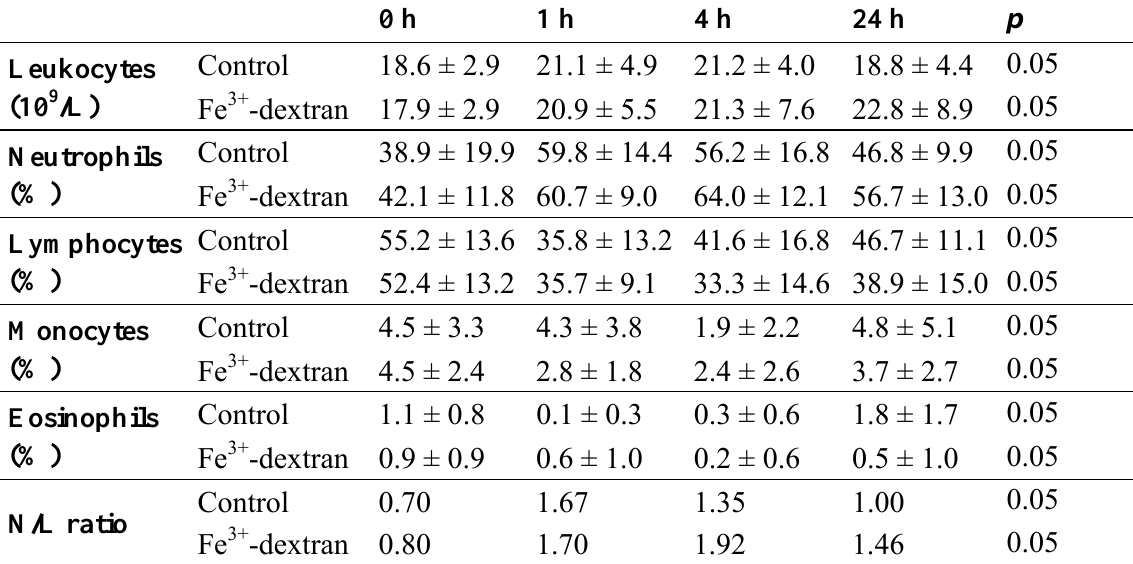
Table 2. Differential leukocyte counts. N/L ratio = Neutrophils